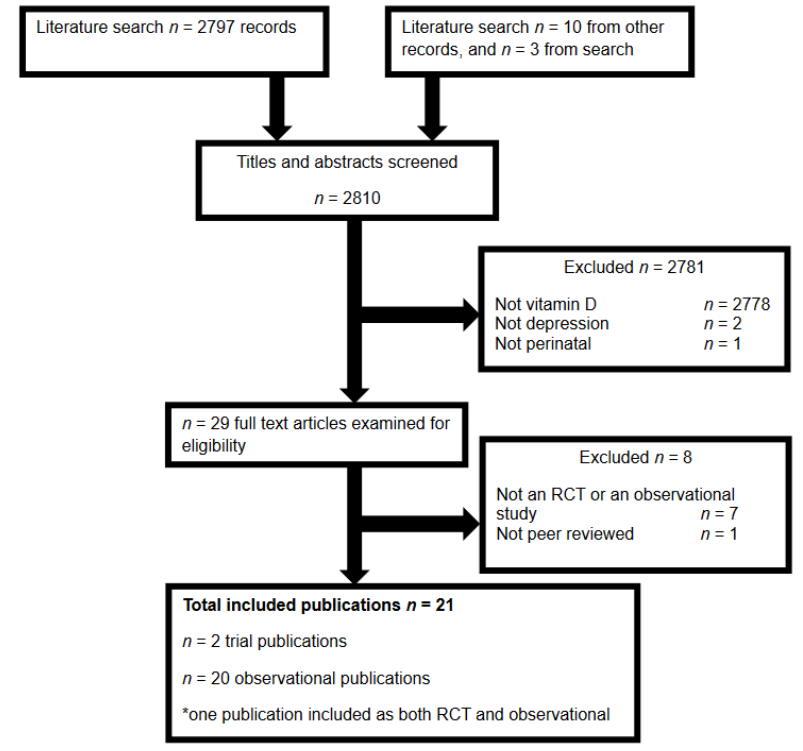
Figure 1. Flow of publications through the literature search and screening for eligibility.